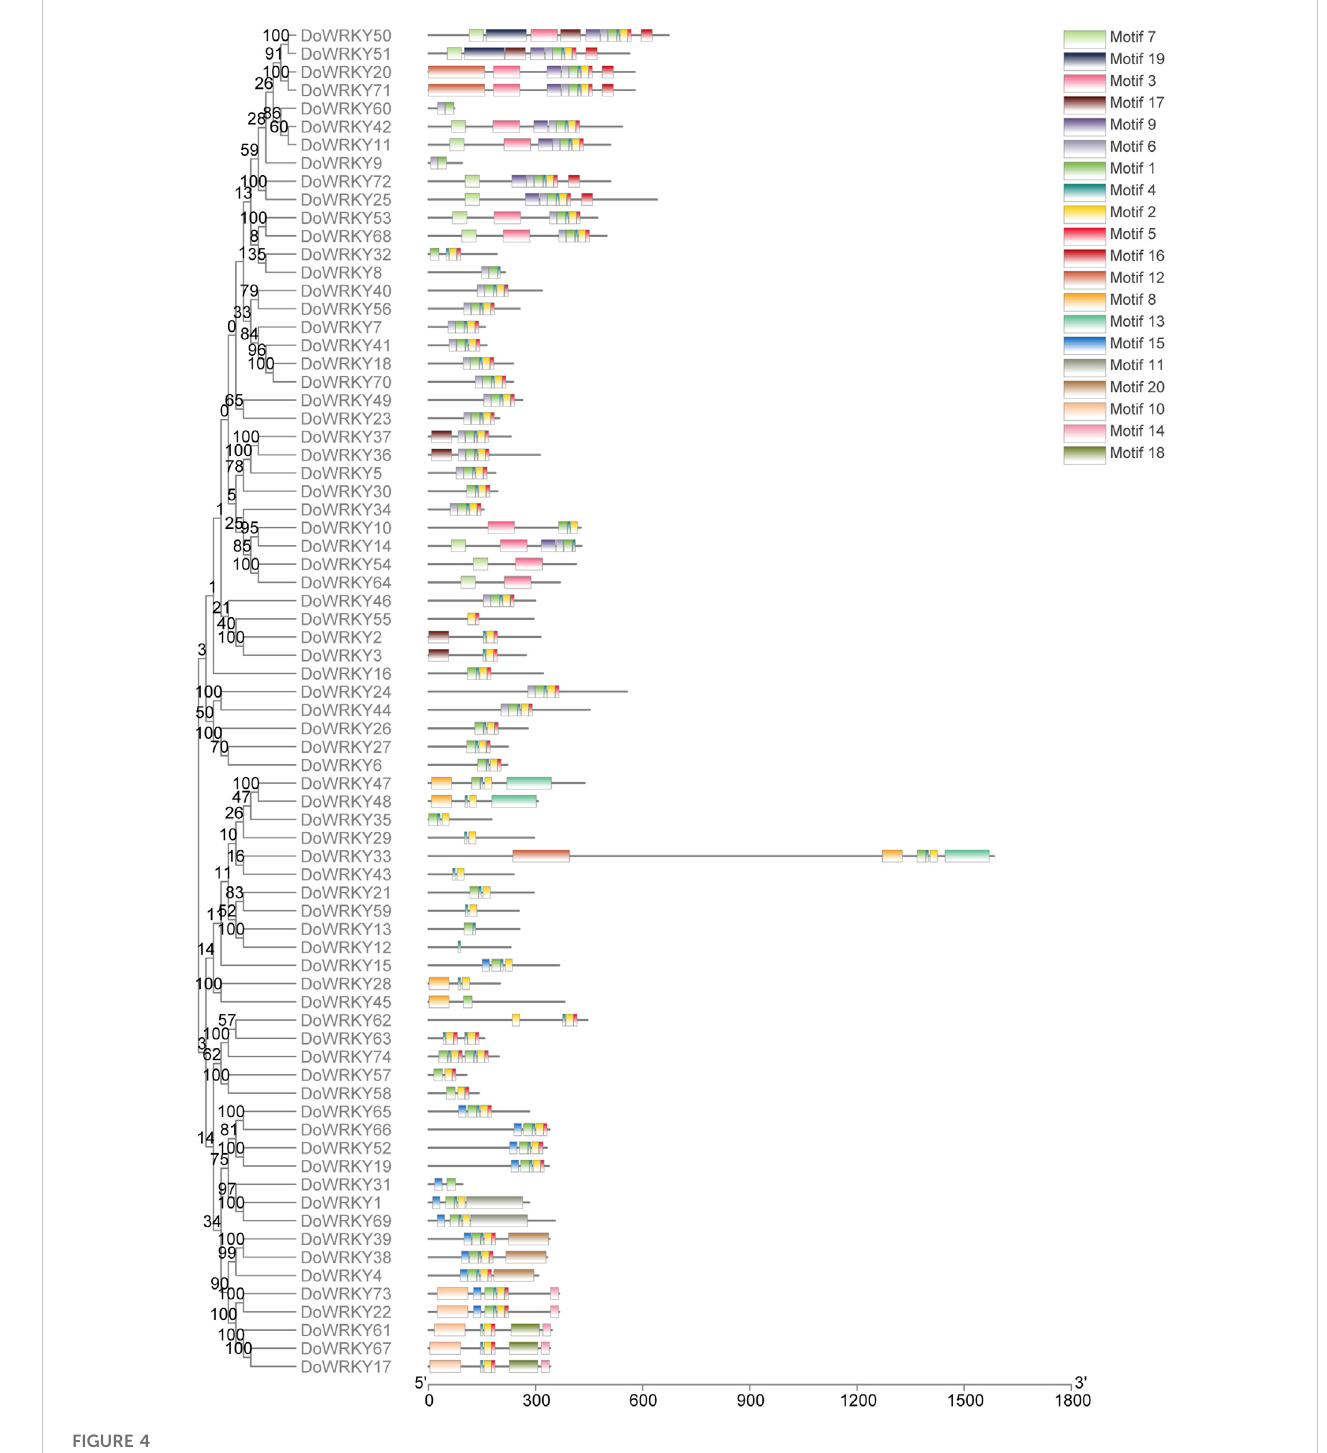
Analysis of the conserved motifs of DoWRKY